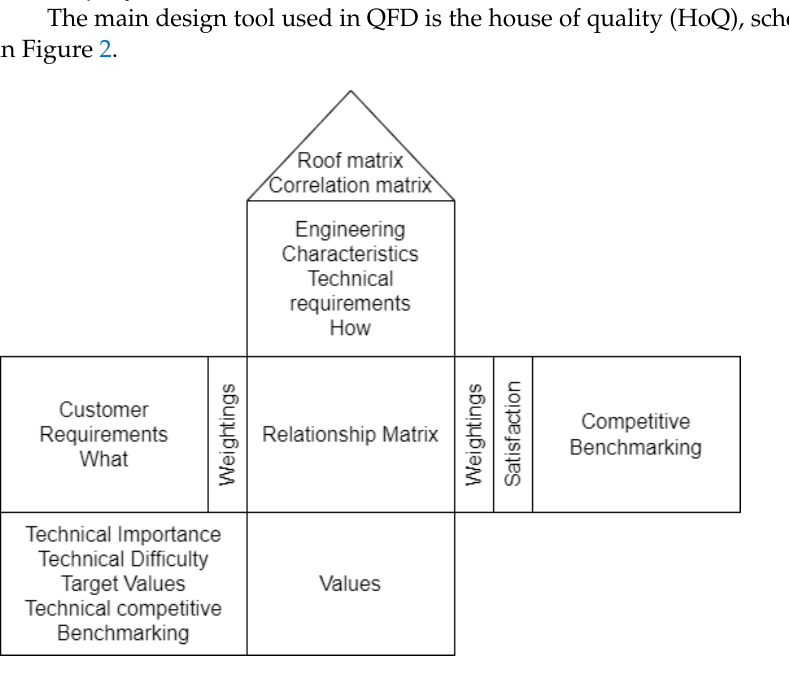
Figure 1. Life cycle of a product [6,9].